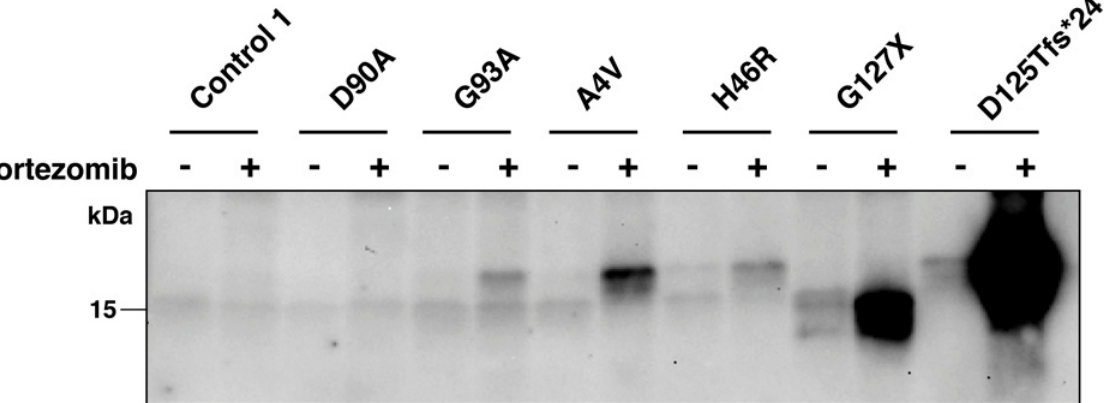
Fig 4. Inhibition of proteasome causes accumulation of detergent-insoluble SOD1 aggregates. Fibroblast cell lines were cultured in the absence (-) and presence (+) of bortezomib (5 ng/ml) for 24 h. Detergent insoluble fractions were analysed by western blotting using the anti-SOD1 (57 – 72 aa) antibody. No insoluble aggregates were seen in the control and D90A lines. Proteasome inhibition increased the amount of aggregates in G93A, A4V, H46R, G127X and D125Tfs * 24